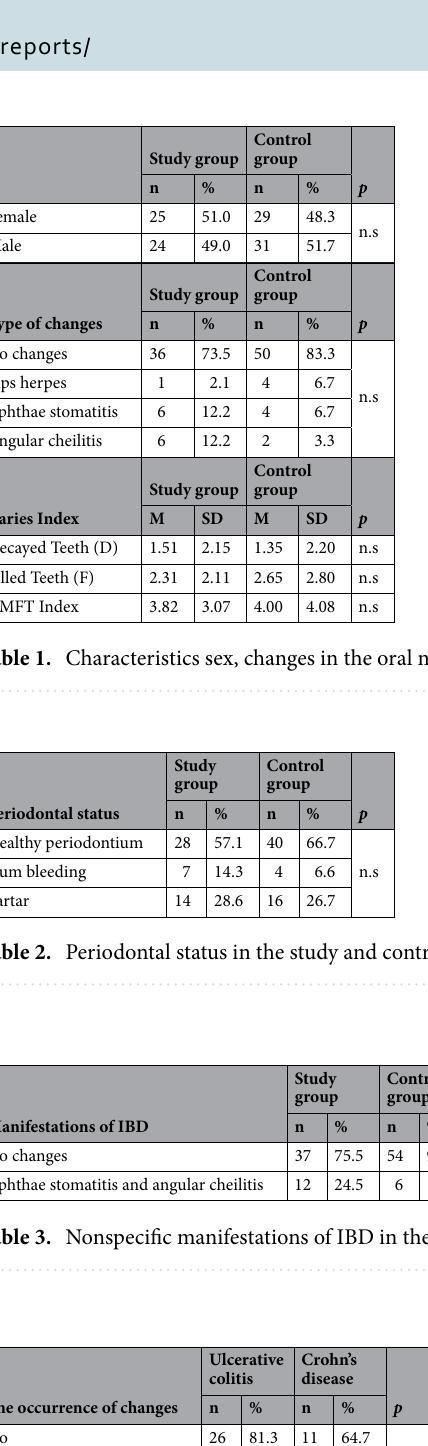
The occurrence of changes